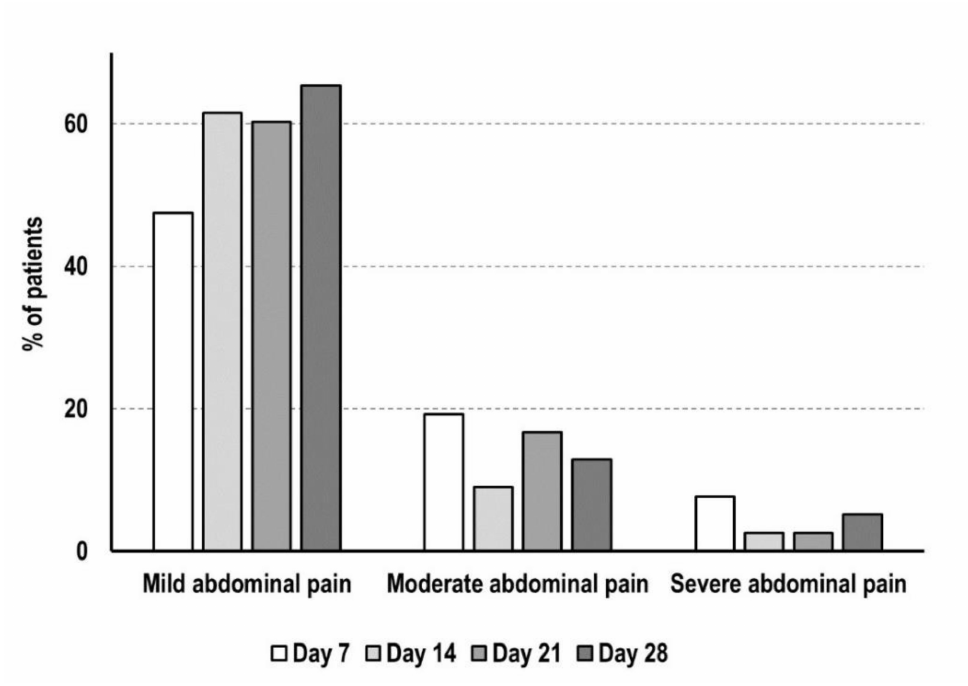
Figure 5. Abdominal pain in patients completing the 4 weeks of follow-up. Data are shown as percentage of patients reporting the adverse reaction to naloxegol for each